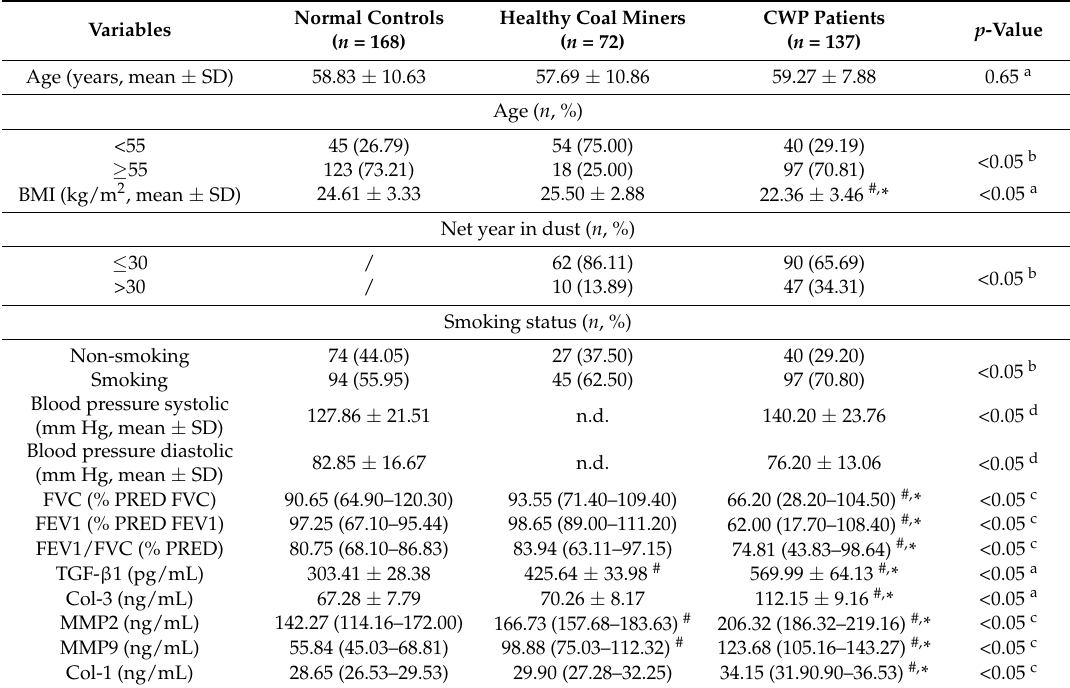
Figure 1. Scatter plots of lncRNA-ATB expressions in different groups. Solid circles, healthy controls; Solid squares, healthy coal miners; Solid triangles, CWP patients. (* p < 0.05). Table 1. Basic characteristics of the study population.